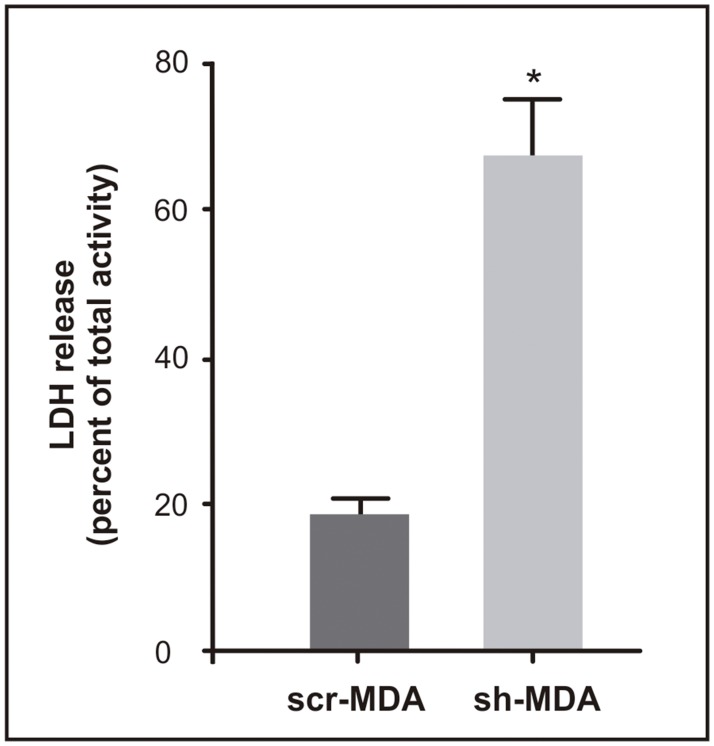
GPAT2 silencing disrupts membrane integrity.Cells were grown in a 48-well microplate and LDH activity was determined in the cellular supernatants and in total cell lysates using a commercial colorimetric method. Results are expressed as the percentage of LDH activity in the supernatants for each cell line. Results are the means ± SD of 3 independent experiments. (* p<0.05)